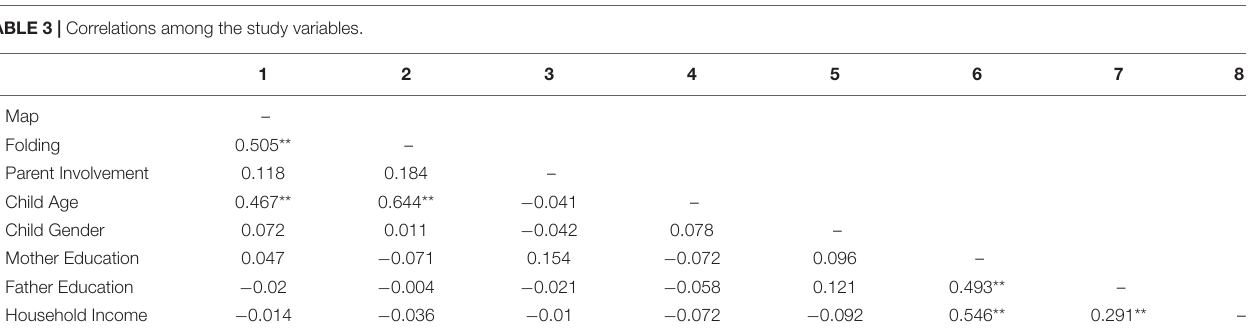
TABLE 3 | Correlations among the study